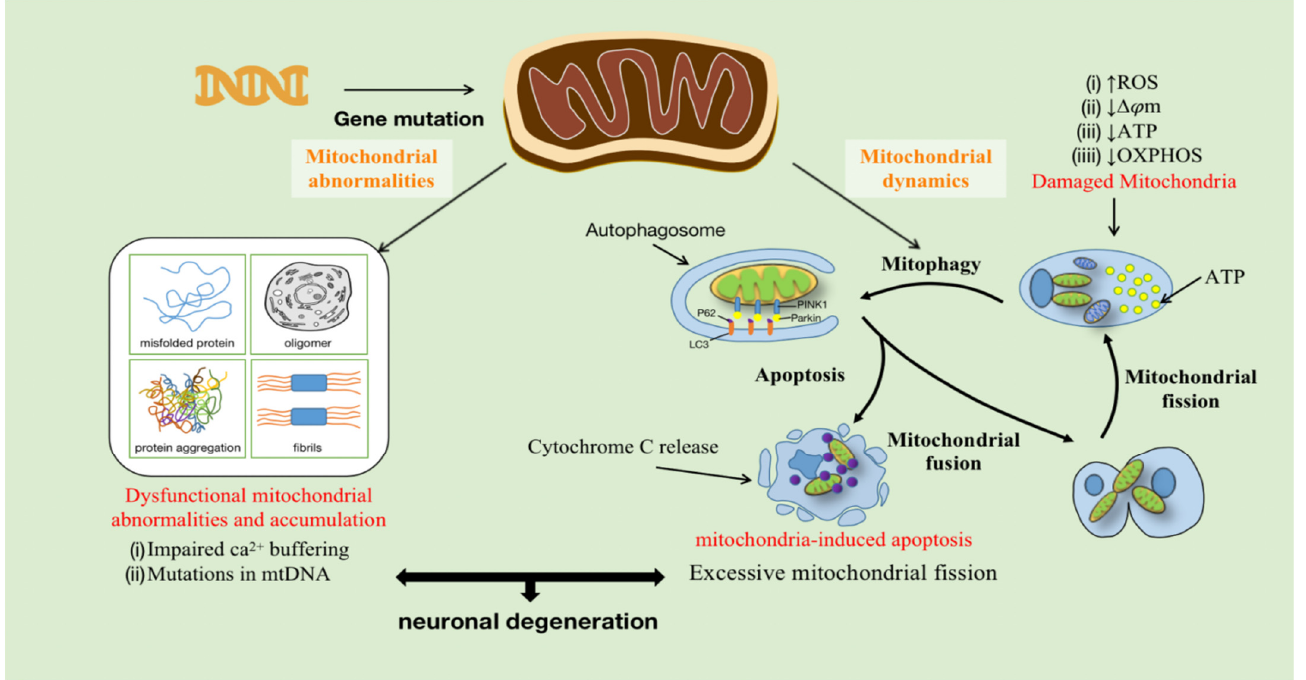
Figure 1. Mitochondrial genes such as FUS, SOD1, and CHCHD10 are mutated in ALS patients, leading to mitochondrial damage. During mitochondrial fission, OXPHOS decreases due to im- paired mitochondria, which results in decreased ATP production, decreased transmembrane potential ( ∆ ψ m), and increased ROS production, while damaged mitochondrial components are eliminated by autophagy. Furthermore, higher mitochondrial membrane permeability leads to increased release of cytochrome C, promoting the production of more pro-apoptotic proteins. Mutations in mitochondrial DNA (mtDNA) and excessive mitochondrial shedding lead to synaptic dysfunction, axonal degeneration, and ultimately neuronal degeneration and death.